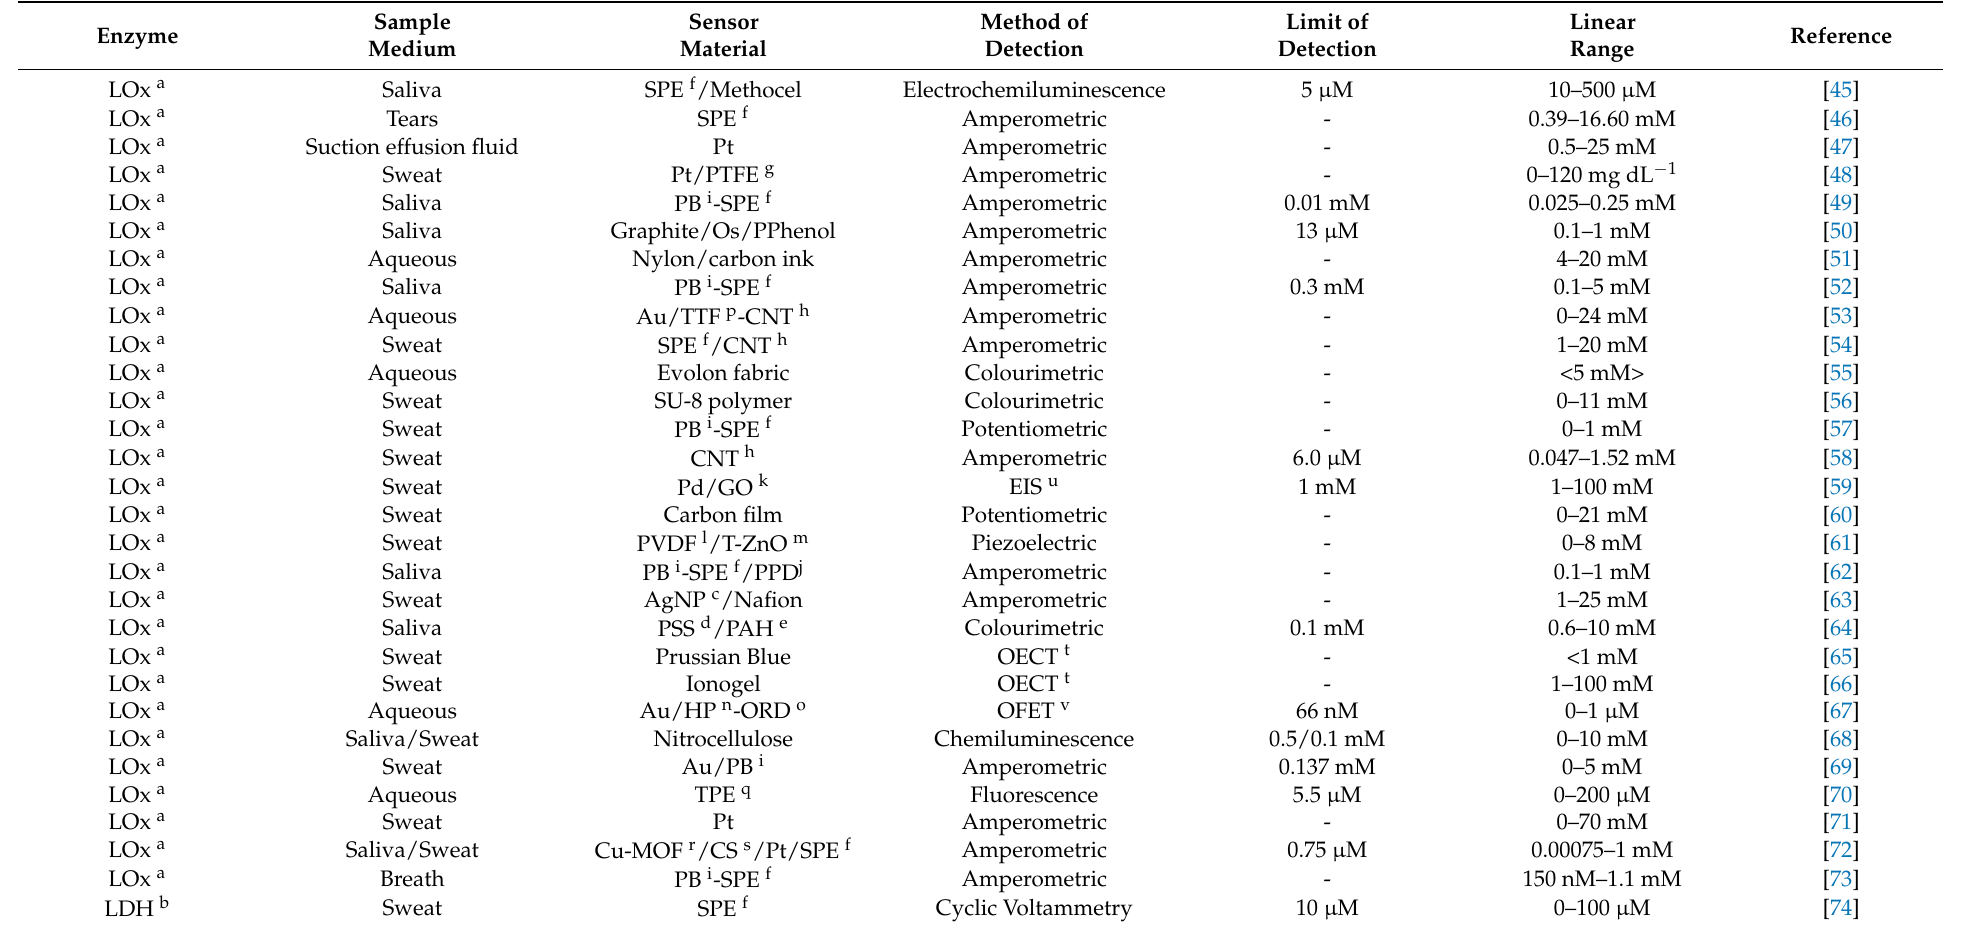
Table 2. Summary of enzymatic sensor platforms for the detection of lactate, highlighting the enzyme, materials used, method of detection, biological medium, linear range, and limit of